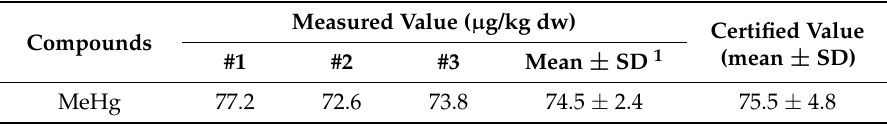
Table 2. Analysis of methylmercury from reference materials ERM-CC580 (estuarine